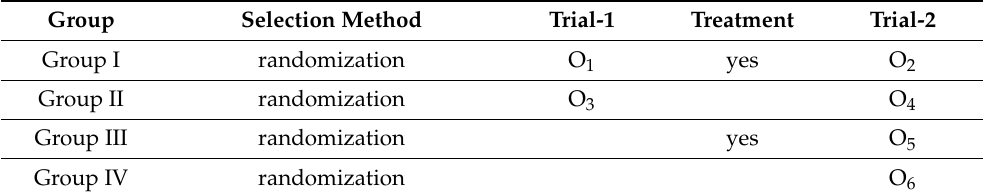
Table 1. Scheme of observation